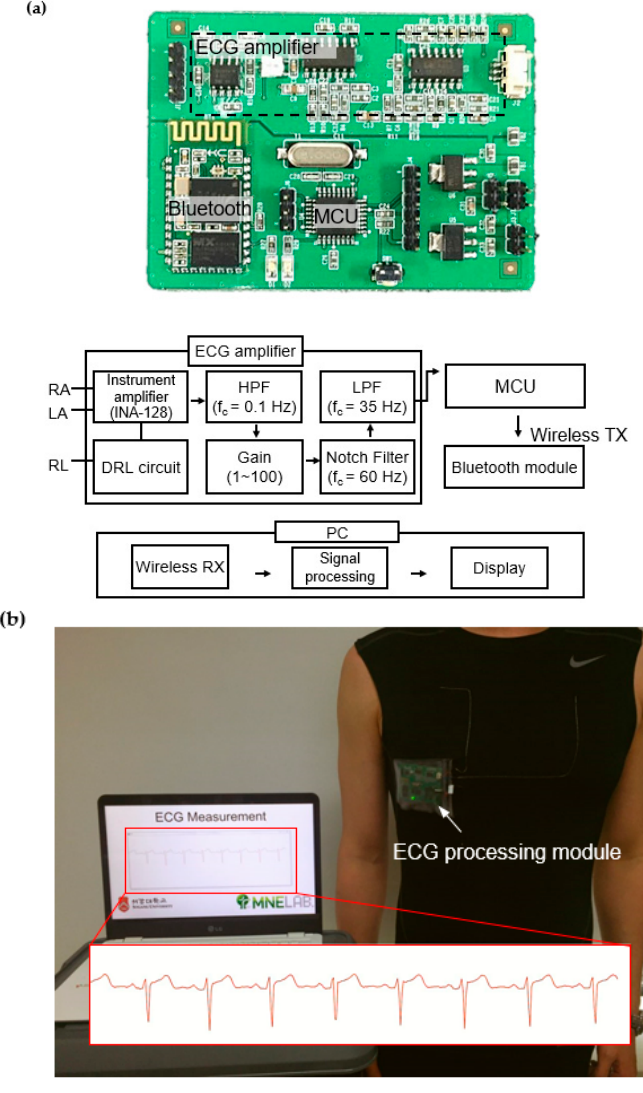
Figure 13. ( a ) ECG processing module and its functional block diagram; and ( b ) ECG measurement garment with the ECG processing module and the wirelessly-transmitted ECG signal. MCU: Microcontroller, RA: Right arm, LA: Left arm, RL: Right leg, DRL: Driven Right Leg, HPF: High pass filter, LPF: Low pass filter, TX: Transmitter, PC: Personal computer, RX: Receiver.